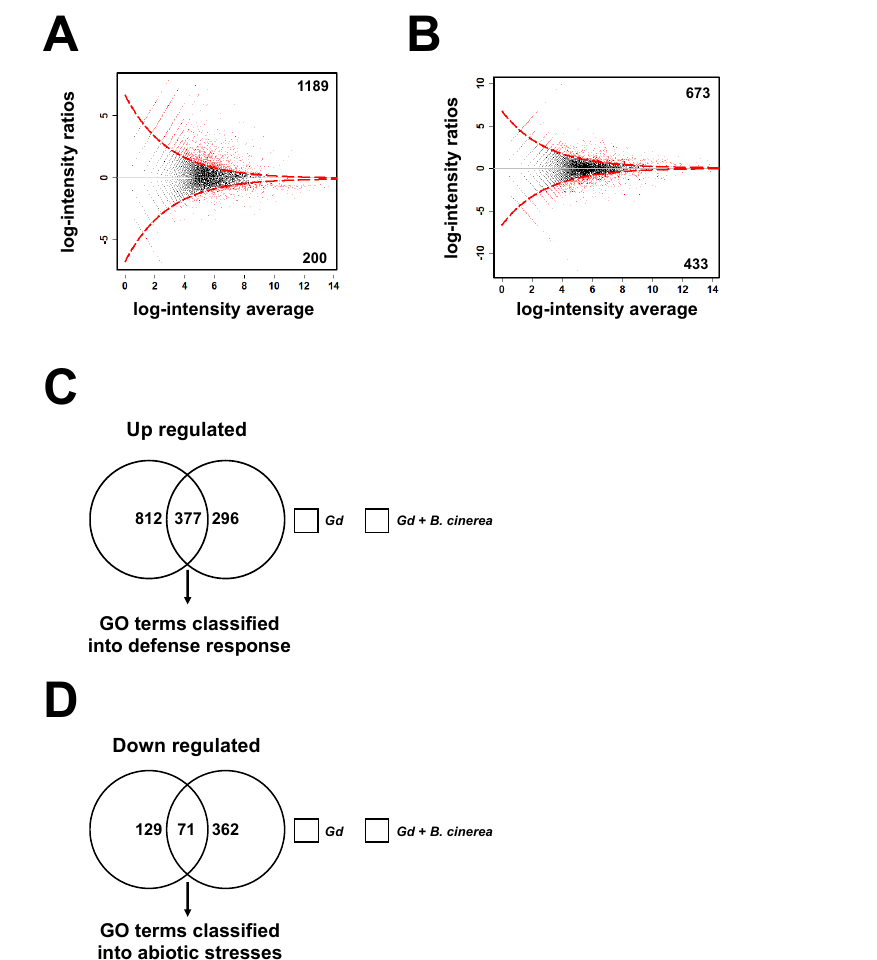
Figure 6. RNAseq analysis of Gd-induced A. thaliana plants. Five 4-week-old A. thaliana plants were sprayed until saturation with 0.2 g/L of Ca or Gd (24 hpt) and then infected with B. cinerea (24 hpi). Total RNA for each condition, from three independent experiments, was pooled and sequenced (RNA-seq). ( A ) MA plot of Gd- versus Ca-treated samples at 24 hpt. ( B ) MA plot of Gd- versus Ca-treated samples infected with B. cinerea at 24 hpi. The red points represent DEGs ( p -value < 0.05), while black dots indicate genes with a similar expression. The dotted red line shows the limit between similarly and differentially expressed genes. The black horizontal line at zero provides a visual check for symmetry. Venn diagrams representing overlapping or non-overlapping gene sets of up-regulated DEGs ( C ) and down-regulated genes ( D ), respectively, were identified in A. thaliana plants induced with 0.2 g/L of Ca or Gd and infected with B. cinerea , as indicated.